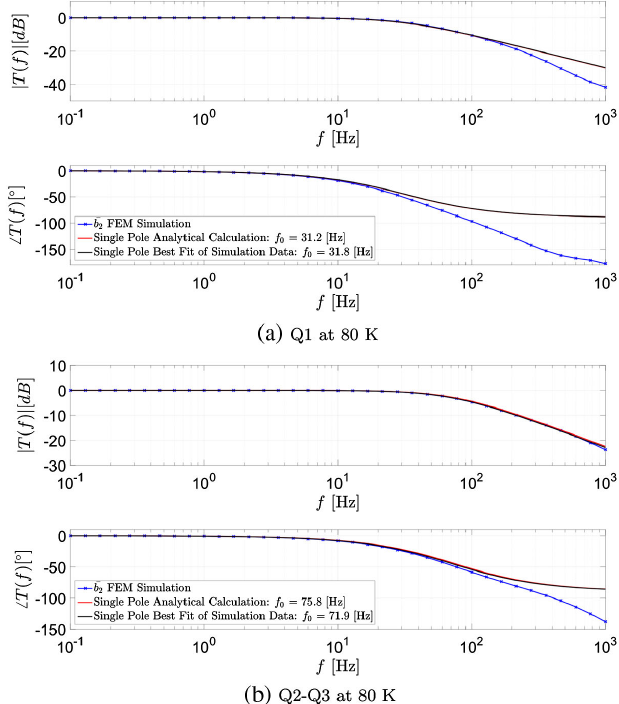
FIG. 13. Frequency response of the shielding effect inside the HL-LHC quadrupoles.